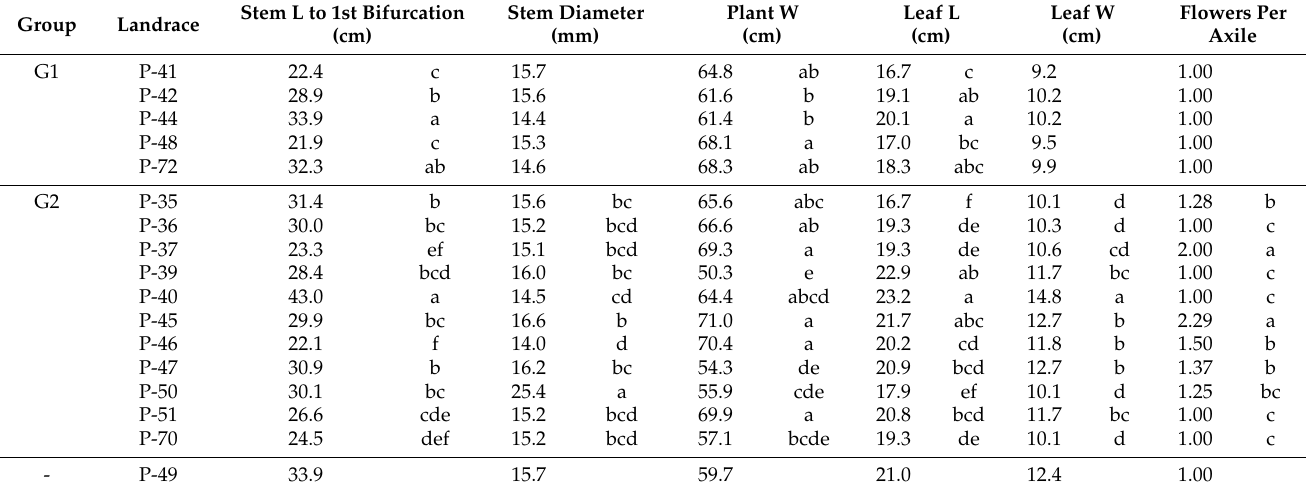
Table 2. Quantitative traits for conventional morphologic descriptors in plant, leaf, and flower of 17 local pepper landraces cultivated in Spain. Statistics were performed by the formed groups based on fruit shape; G1 = elongated; G2 = triangular, square or blocky. Data belonging to the outlier ungrouped landrace (-, P-49 landrace) are also shown. For each landrace, values represent the mean for the studied conventional morphological descriptors ( n = 8). Different letters in a group indicate significant differences at p ≤ 0.05 (LSD test). L: length; W: width; FW: fresh weight; DW: dry